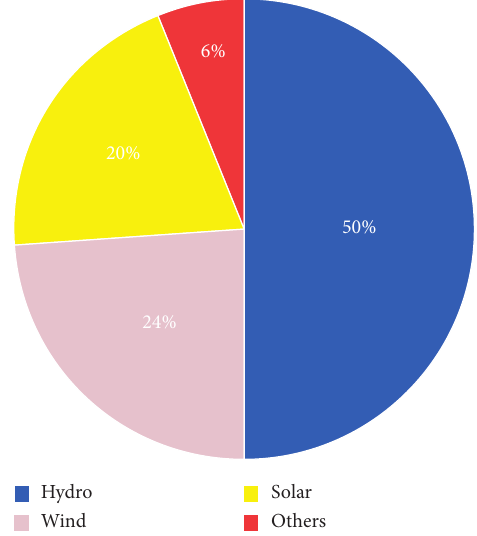
Figure 1: Renewable generation capacity by energy source [1].